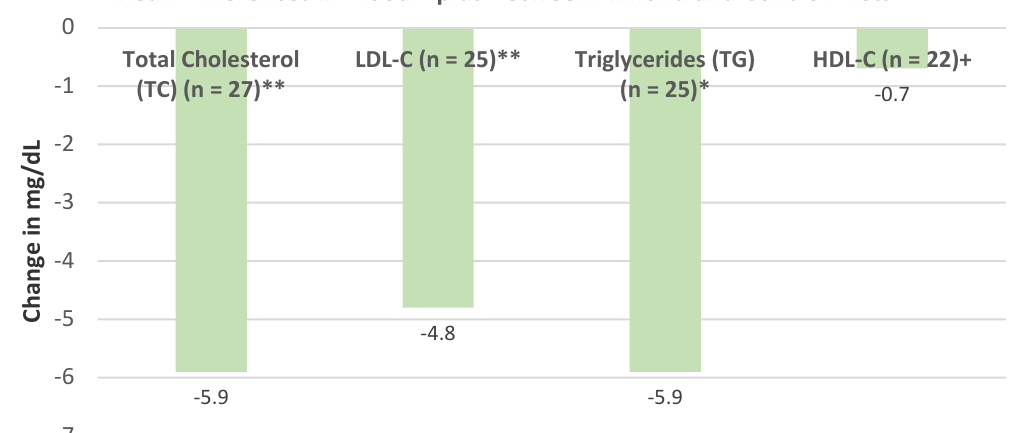
Figure 17. Meta-analysis on mean differences in blood lipids between dose of almonds and control diets for ≥ 45 g doses of TC and LDL-C p = 0.001, and TG and HDL-C p ≤ 0.188, and <45 g doses of TG p = 0.199 and TC, LDL-C and HDL-C p ≥ 0.470 [69].